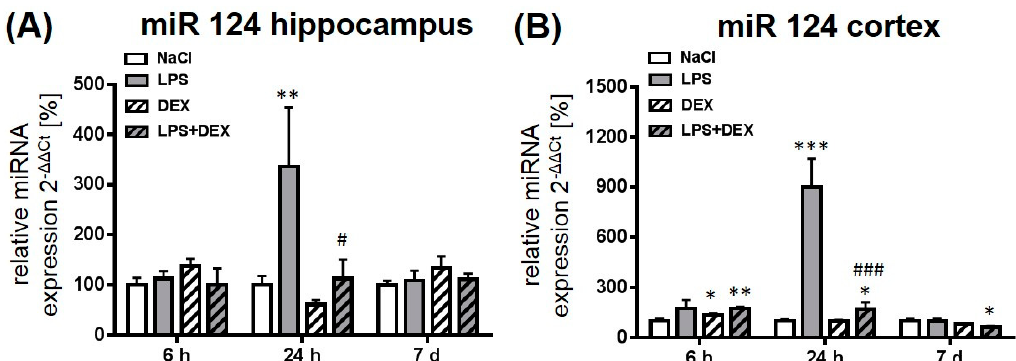
Figure 2. Representation of miR 124 expression after LPS and dexmedetomidine treatment in the hippocampus ( A ) and cortex ( B ). Results are shown as mean ± SEM ( n = 6–8 per group). Data are normalized to levels of saline-treated rats (control = 100%). * p < 0.05, ** p < 0.01, and *** p < 0.001 represent the difference compared to saline-treated groups. # p < 0.05 and ### p < 0.001 represent the difference between LPS and LPS in combination with dexmedetomidine-treated groups.